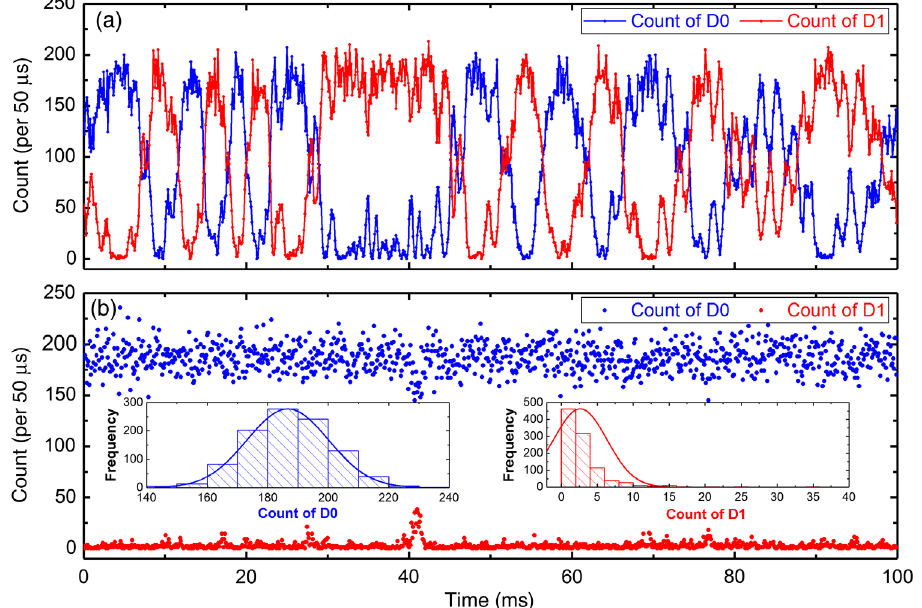
FIG. 3. Characteristics of the compensation of the fast phase drift at a total distance of 300 km optical fiber. (a) The phase drift by recording the counts of D0 and D1 when the driving voltage over the feedback PMs is disconnected. (b) The results of actively compensating the phase drift by recording the counts of D0 and D1 after connecting the PM driving voltage. The insets are the distributions of the counts of two SSPDs. Here, only the counts belonging to the reference parts are recorded.